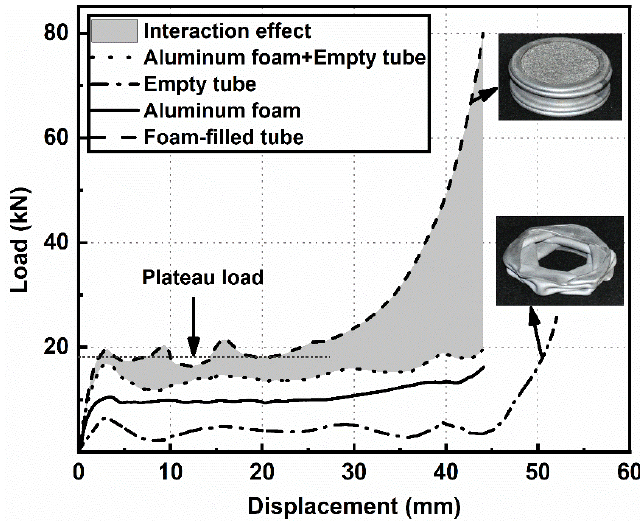
Figure 5. Illustration of the interaction effect in the foam-filled (0.54 g/cm 3 ) tube; the dotted line shows the average crushing loads.